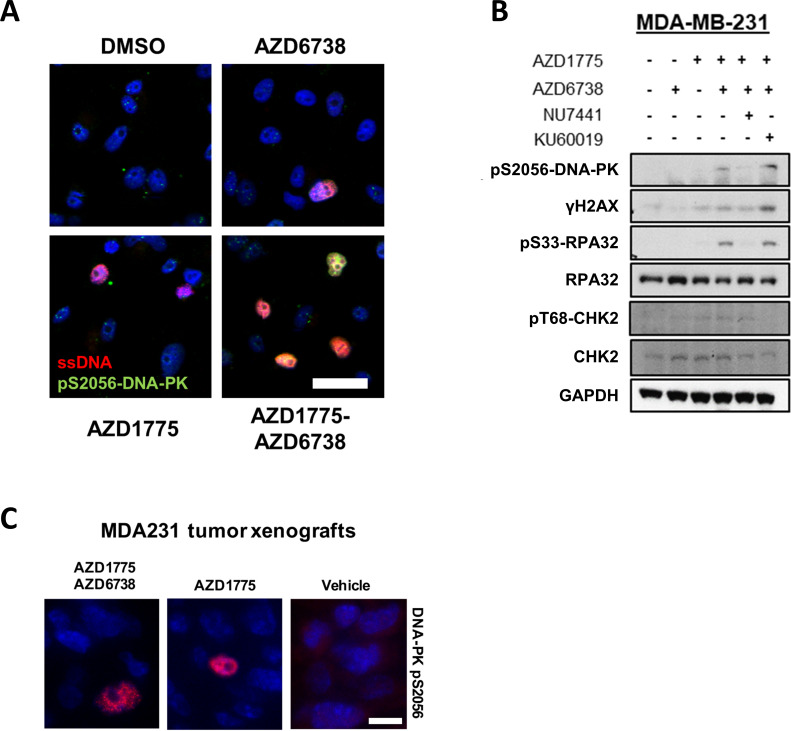
DNA-PK is phosphorylated in response to AZD1775 and preserves CHK1 phosphorylation independent of ATR.(A) Representative immunofluorescence images for staining of pS2056-DNA-PK (green) and BrdU/ssDNA (red) in MDA-MB-231 cells treated with AZD1775, AZD6738, AZD1775-AZD6738 combination or DMSO for 24 hr. Scale bar = 30 μm. (B) Phosphorylation of DNA-PK (pS2056), RPA32 (pS33-RPA32) and CHK2 (pT68) in MDA-MB-231 cells treated with the indicated drugs (AZD1775 (500 nM), AZD6738 (1 μM), NU-7441 (DNA-PK inhibitor, 1 μM) or KU-60019 (ATM inhibitor, 1 μM) for 24 hr. Whole cell lysates were collected, immunoblotted and probed with the indicated antibodies. GAPDH levels were used as loading control. (C) DNA-PK phosphorylation in MDA-MB-231 tumours. MDA-MB-231 tumours from mice treated with AZD1775, AZD6738, AZD1775-AZD6730 combination or vehicle control (as in Figure 3B) were formalin-fixed, paraffin-embedded and stained for pDNA-PK-S2056. Representative images are shown. Scale bar = 30 μm.